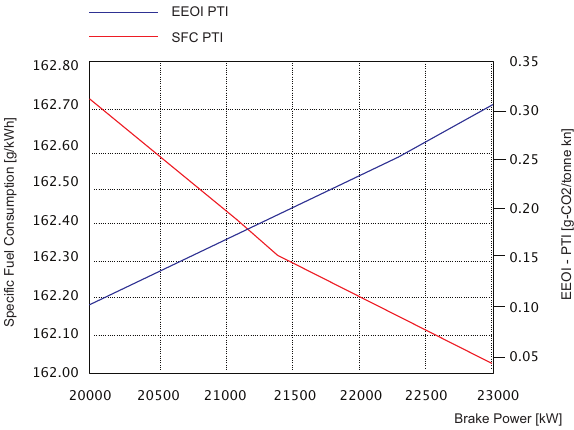
Figure 13. EEOI against SFC at PTI